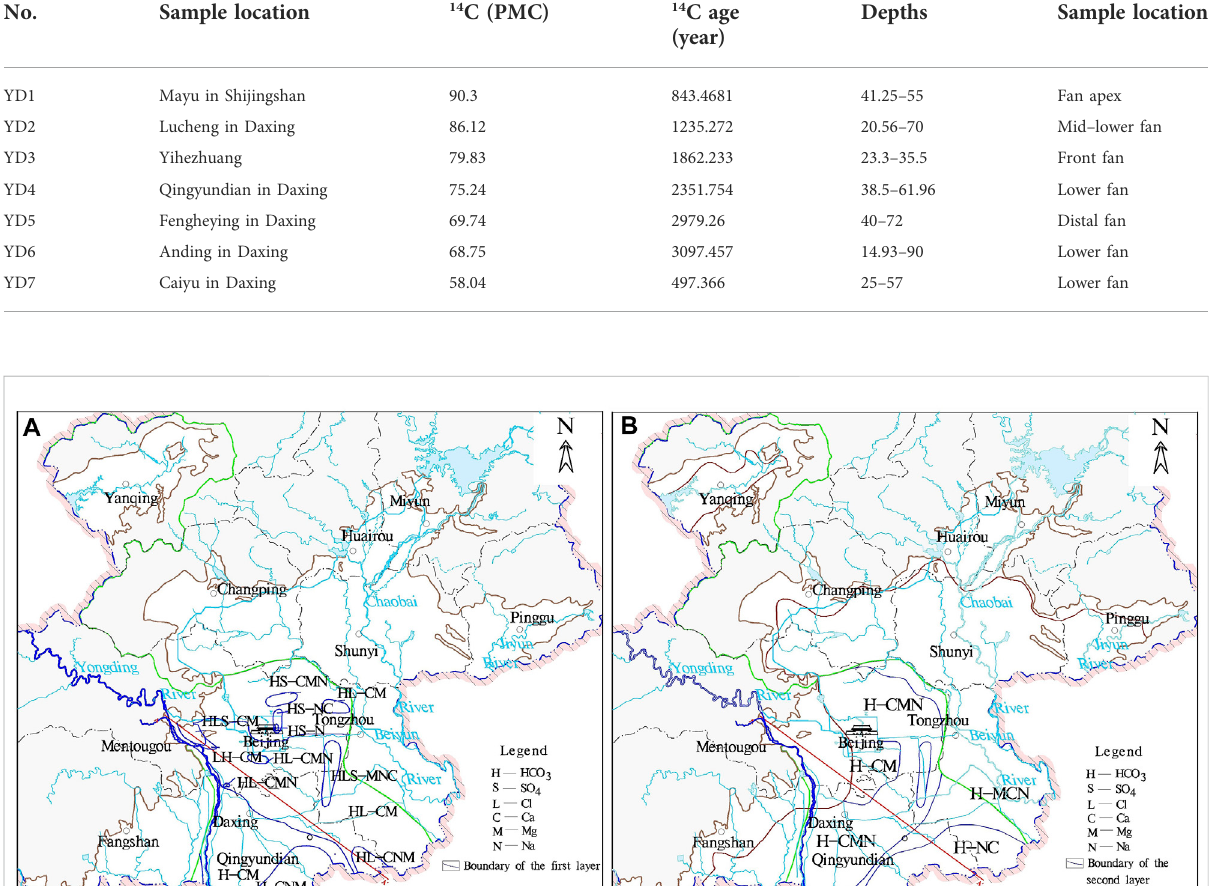
Frontiers in Environmental